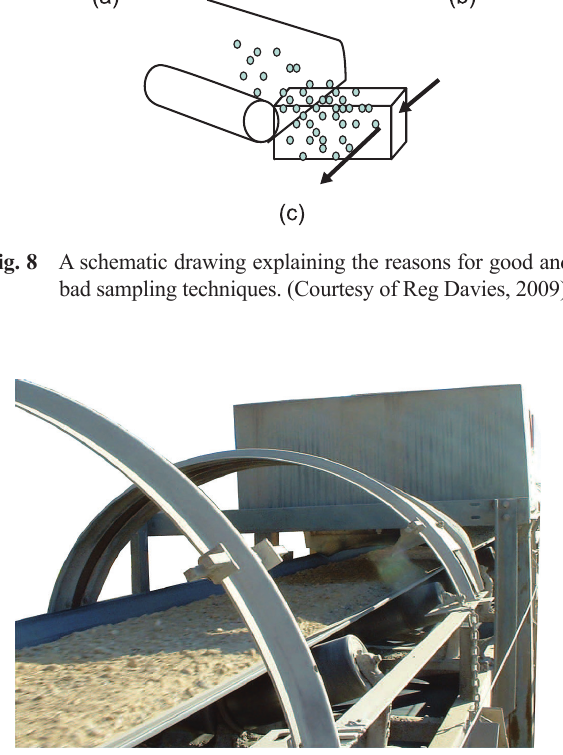
Fig. 9 Sampling a moving belt. (Courtesy of Sentry Equipment, www.sentry-equip.com)